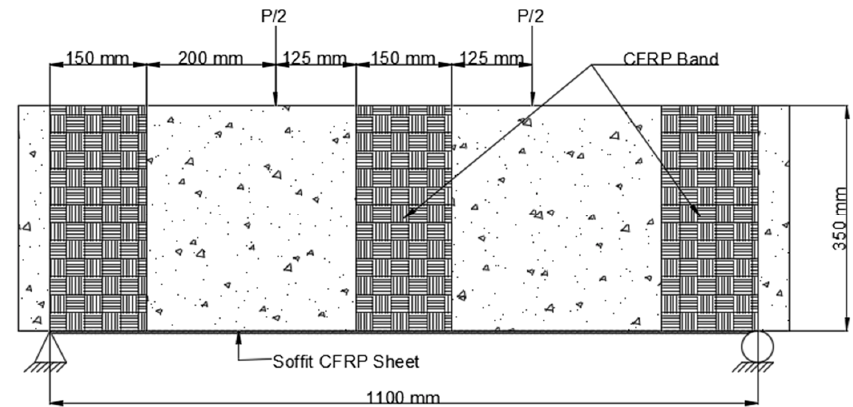
Figure 9. Placement of CFRP on beam Scheme 2 (B2). 3. The CFRP sheet used in Scheme 3 (B3) was 1100 mm long and 200 mm wide, with fibers arranged parallel to the axis of the beam. This CFRP sheet was encased across the side faces of the beam to a height of 65 mm above the tension face, as shown in Figure 10.